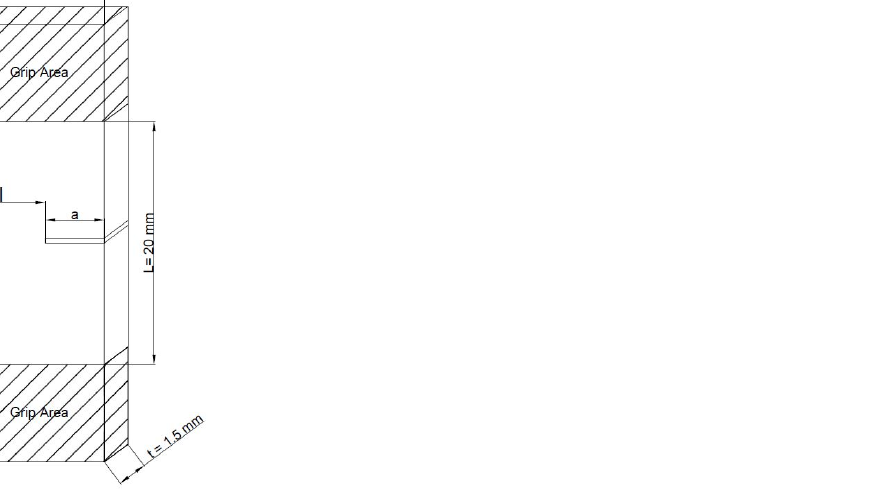
Figure 1. Schematic diagrams showing the single-edge-notched-tension (SENT) .